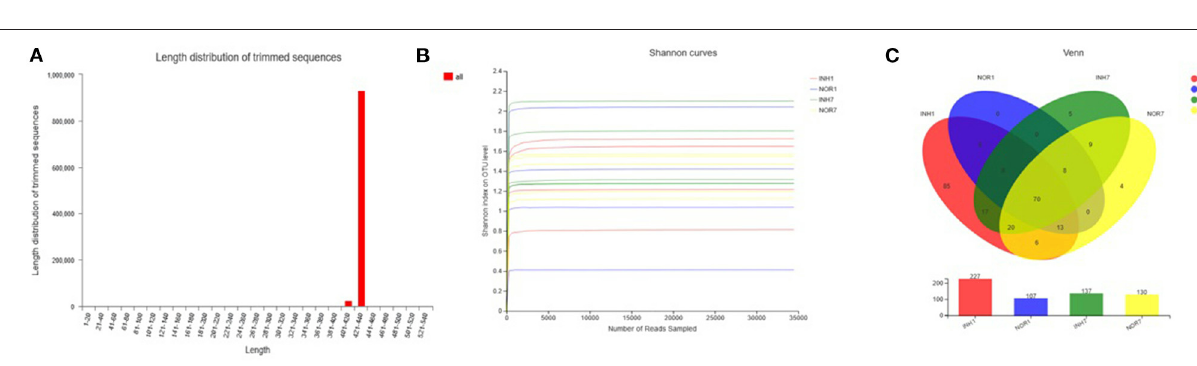
FIGURE 1 | NOR1 vs. INH1: * P < 0.05; NOR7 vs. INH7: 1 P < 0.05.